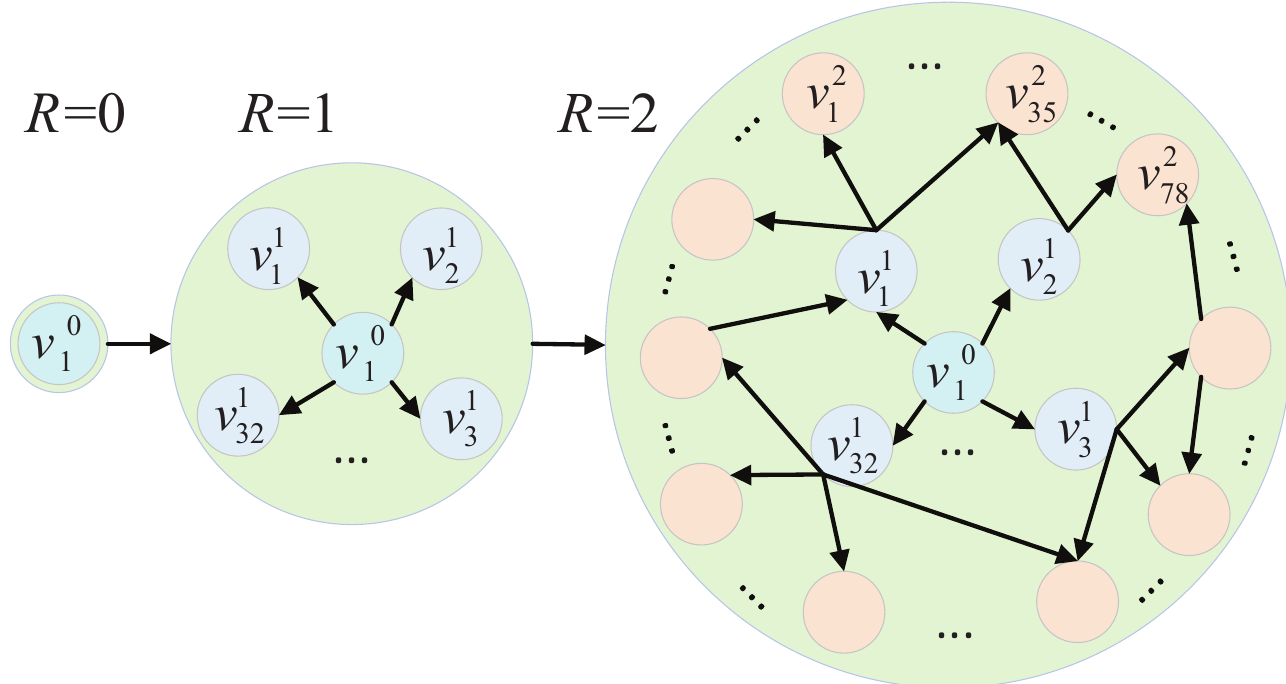
Figure 8. The update of C β as R